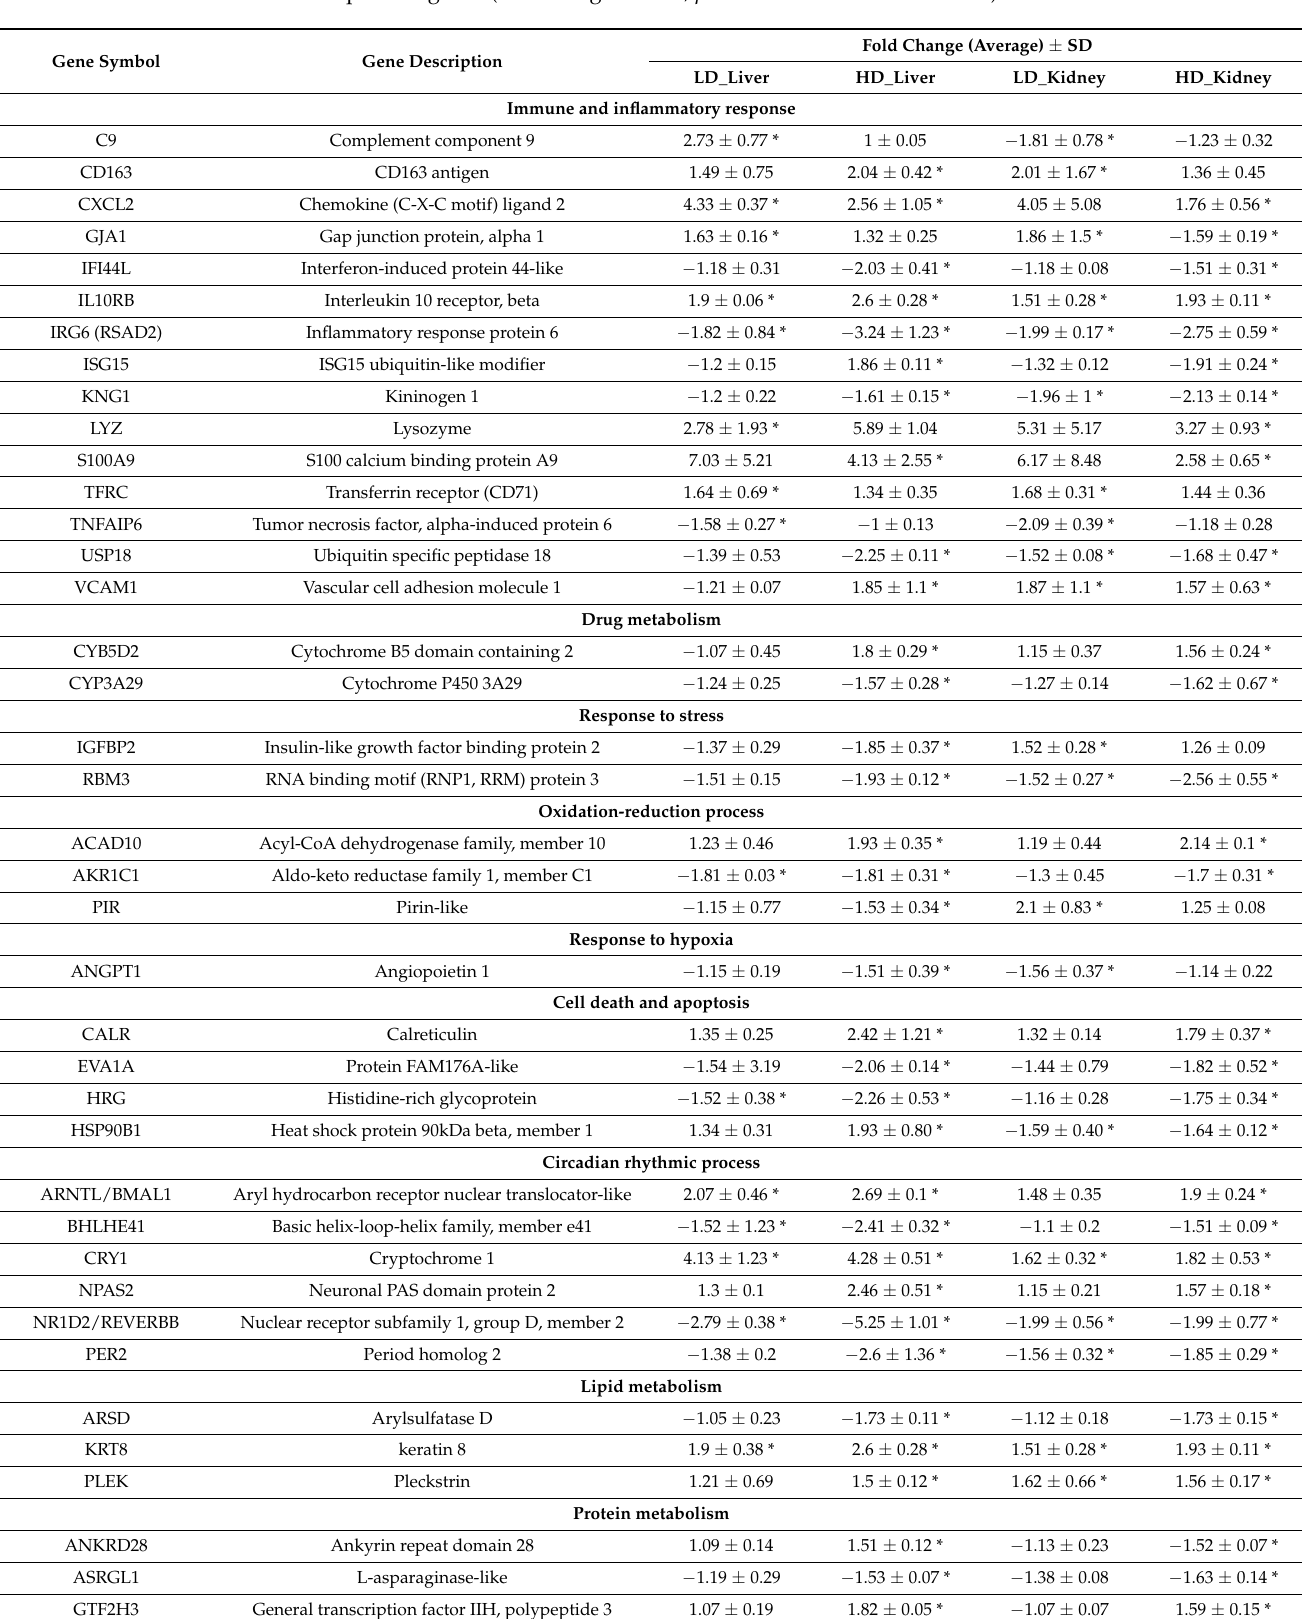
Table 7. Commonly regulated genes in the liver and kidney after diclofenac treatment. * Differentially expressed genes (Foldchange > ± 1.5, p -value < 0.05 and FDR <